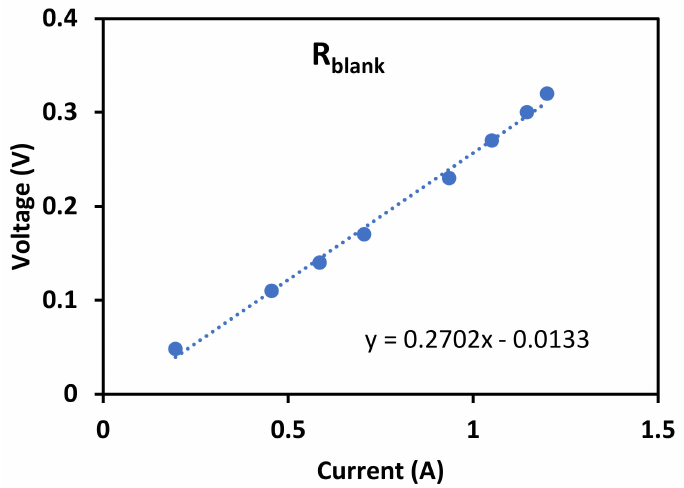
Figure 5. R blank as the slope between voltage and current under the experimental condition of 0.1 M FeK 3 (CN) 6 /FeK 4 (CN) 6 , and 0.6 M NaCl in the electrode compartment, 20 ◦ C temperature, and 180 mL min − − 1 of flow